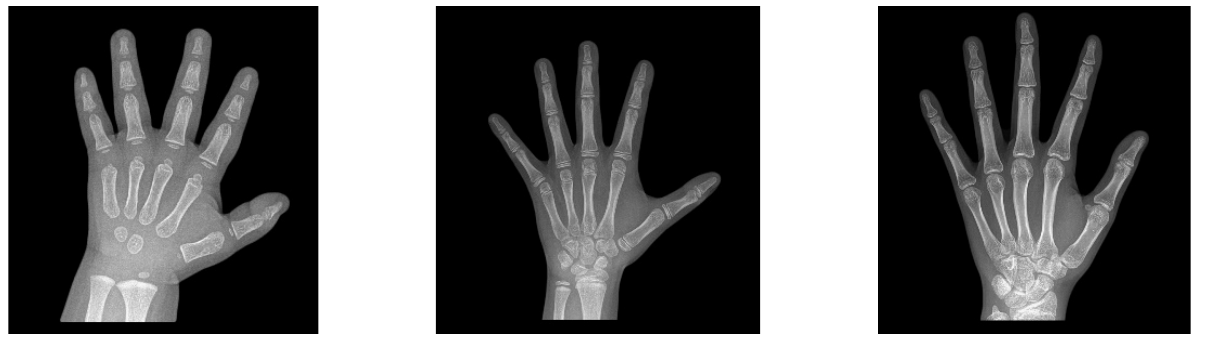
Figure 1. Three-stage metacarpal X-ray images.